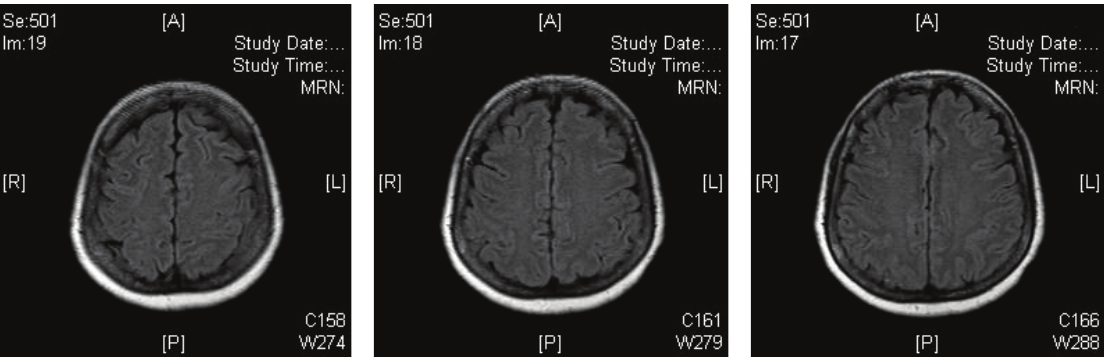
Figure 1: The patient’s MRI on admission.